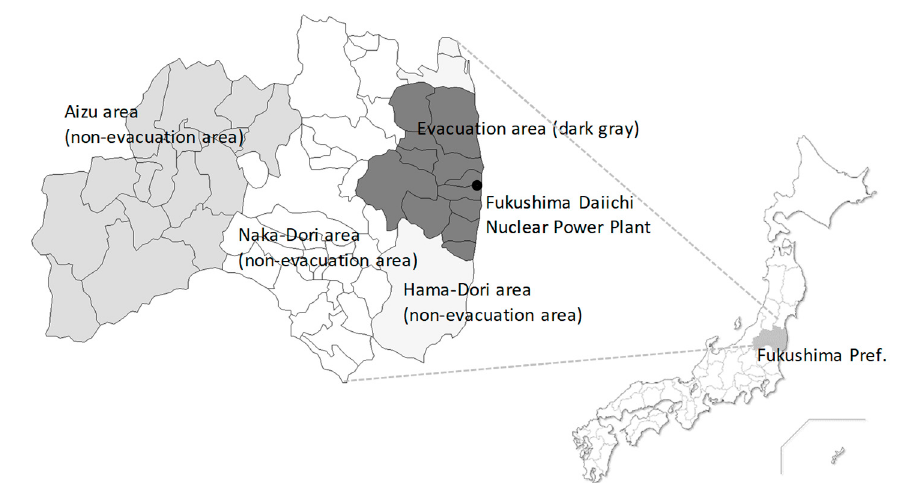
Figure 1. Evacuation and non-evacuation areas around Fukushima. Regions colored in dark gray correspond to municipalities where evacuation orders were issued. Hama-Dori, Naka-Dori, and Aizu were the non-evacuation areas.